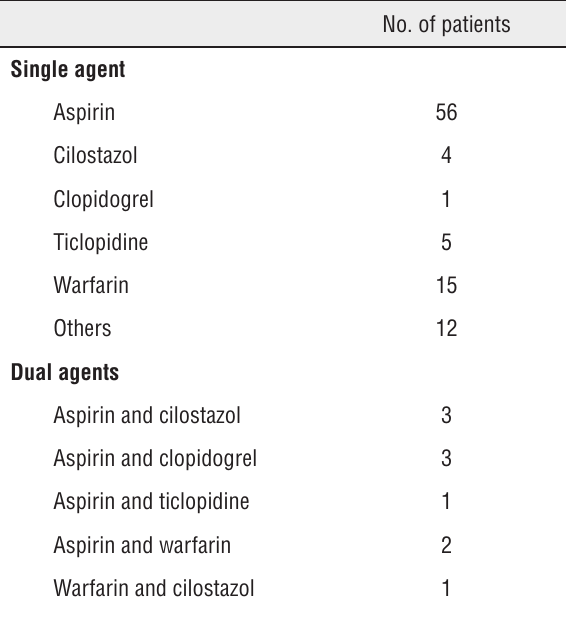
Table 2 - The detail of continuing anti-thrombotic